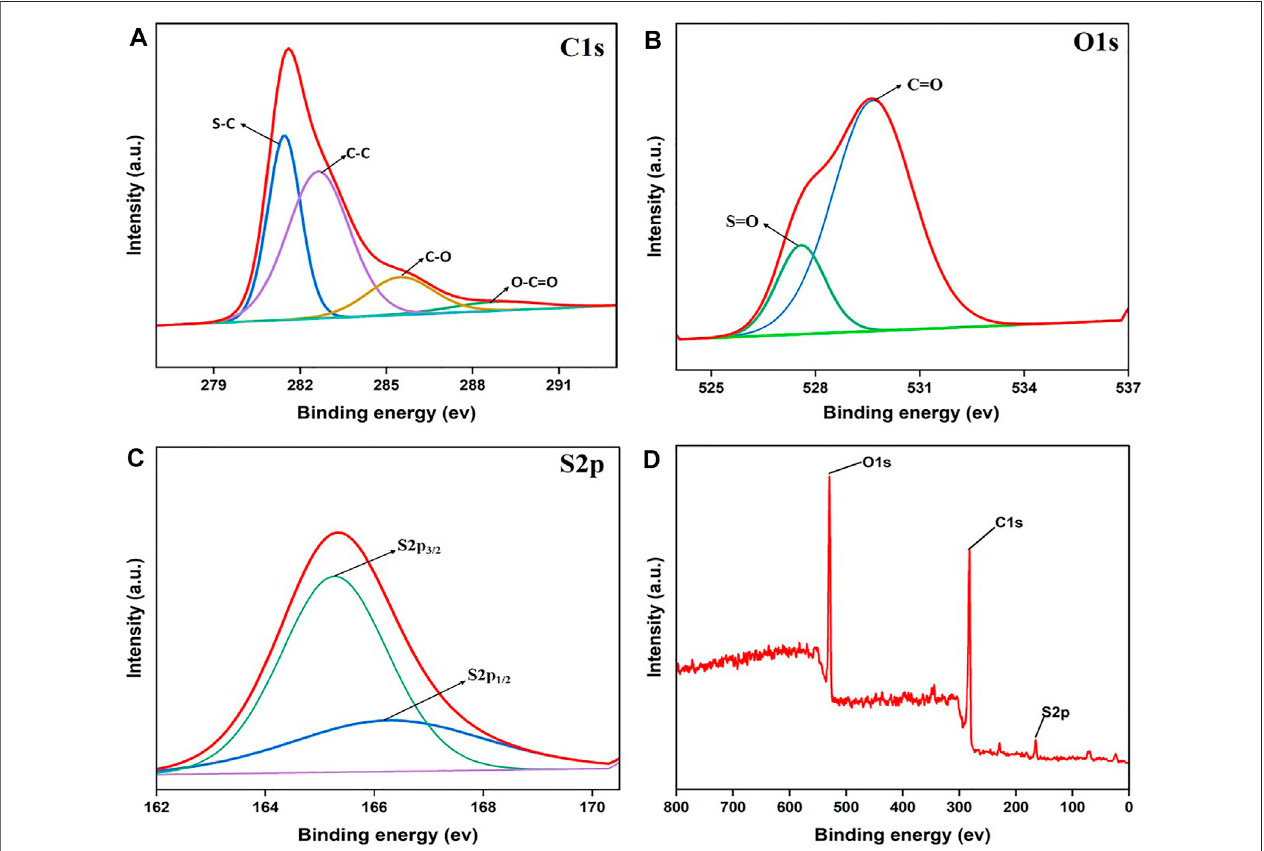
FIGURE 4 | The deconvolution of the XPS spectra of OP-SO 3 H-4. (A) Carbon, (B) Oxygen. (C) Sulfur, (D) Overall XPS spectrum.